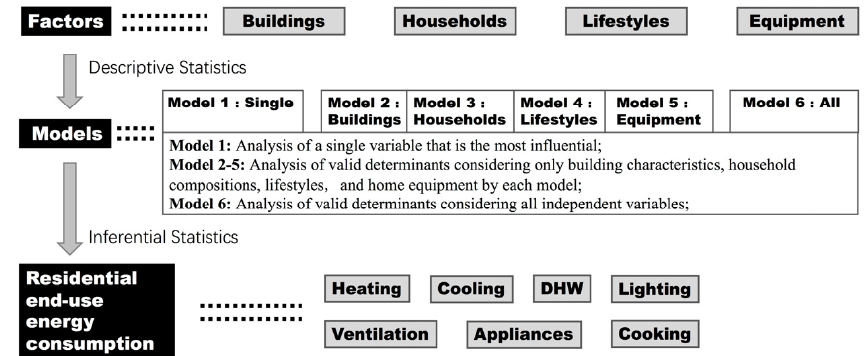
Figure 1. Study conceptual framework.